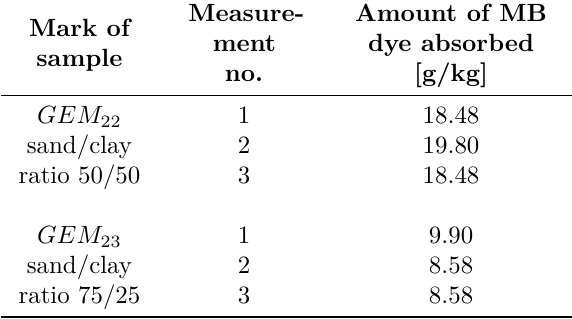
Table 6. Amount of MB dye absorbed by earth samples during methylene blue test without defined stirring time.